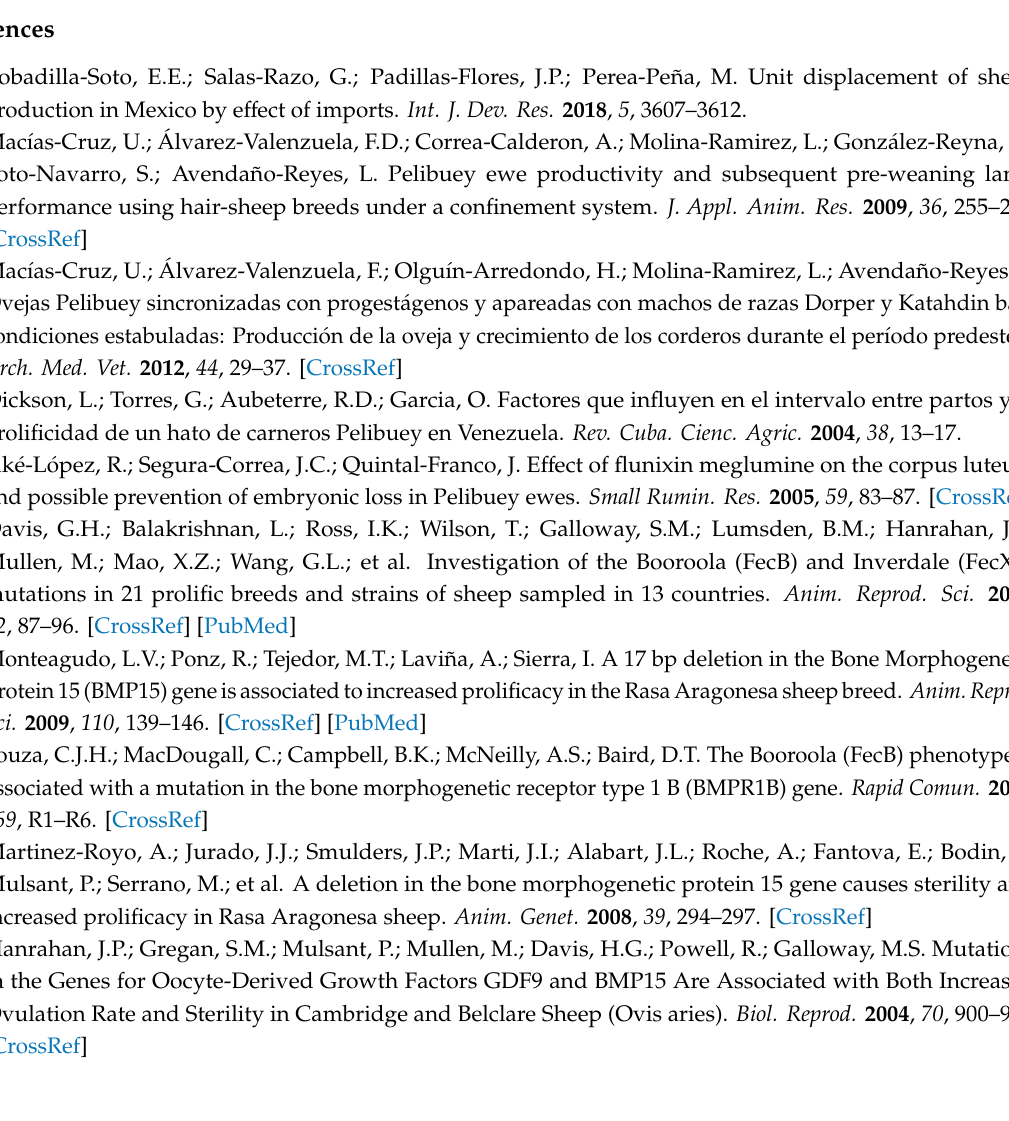
Table S1: 57 SNPs considered as candidate markers and genes mapped; Table S2: Regions of chromosome in SNPs identified in the present study and QTLs previously reported for traits di ff erent in other sheep breeds; Table S3: KEGG pathway analysis in genes with chromosome-wide level